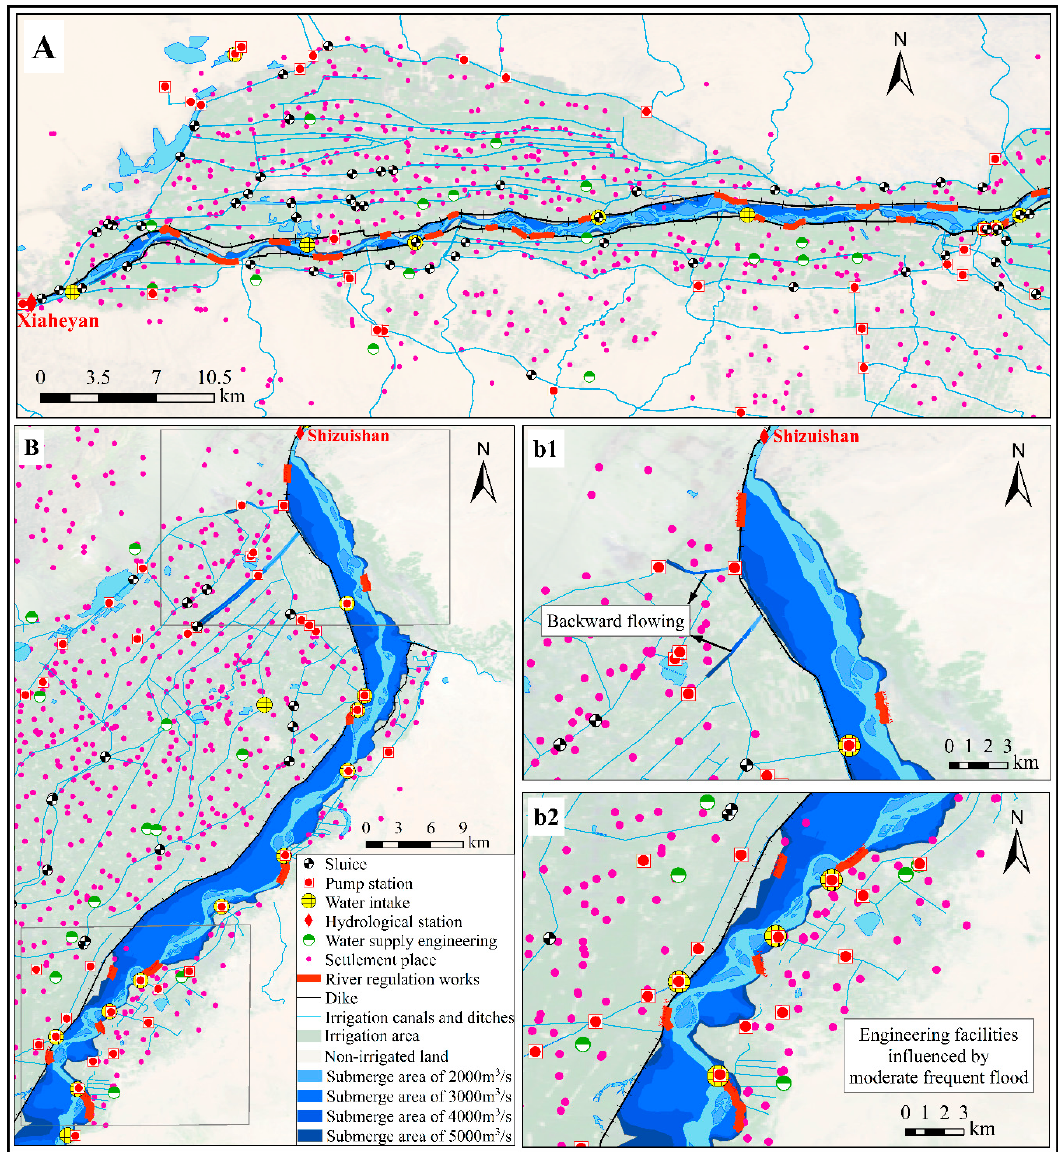
Figure 8. Hazard distribution map of the floodplain and backward flow damages related to the moderate frequent flooding events in local sections of the: ( A ) Weining Reach and ( B ) Qingshi Reach of the NRYR; ( b1 ) hazard map of the floodplain and backward flow; ( b2 ) hazard map of the floodplain and water a ff ected engineering